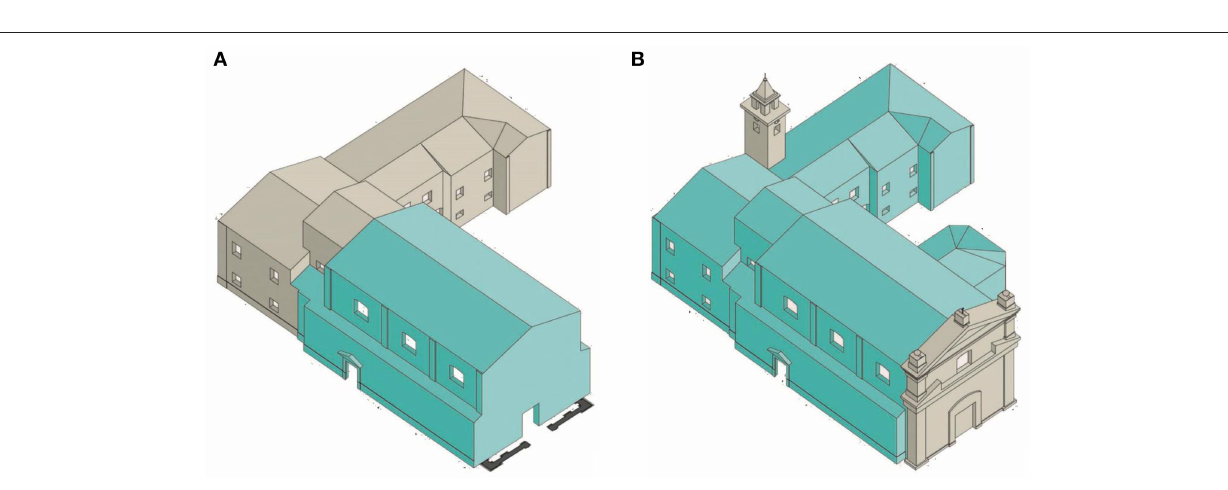
zone between body A and body B, which were erected in different historical